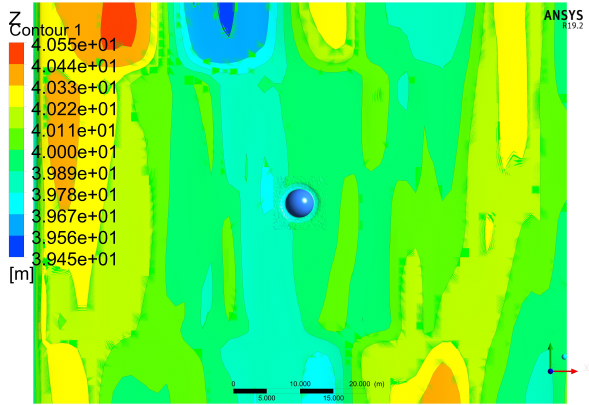
Figure 12. Wave pattern on the free surface at t = 1